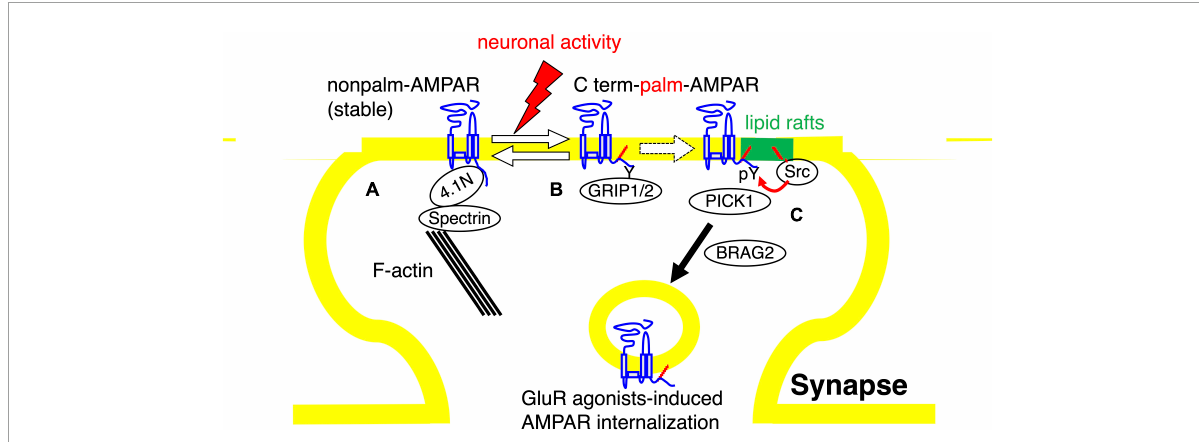
FIGURE3 Model of the role of AMPA receptor palmitoylation in lipid rafts. Diagram of the role of AMPA receptor palmitoylation and tyrosine phosphorylation. (A,B) The balance between palmitoylated and de-palmitoylated forms of the AMPA receptor can be regulated by glutamate receptor agonists treatment, suggesting that synaptic activity can regulate the steady-state level of AMPA receptor palmitoylation. De-palmitoylation of the AMPA receptor on the C-terminal site increases the receptors’ affinity for 4.1N, which stabilizes AMPA receptors at the synaptic surface by the interaction of 4.1N with F-actin and spectrin (A) . In contrast, the palmitoylated forms of surface AMPA receptors are less stably associated with the synaptic membrane and are more susceptible to neuronal activity-induced internalization (B) . (C) The palmitoylated AMPA receptors are assumed to translocate to the synaptic membrane lipid rafts, where the palmitoylated Src family protein tyrosine kinases are concentrated. Phosphorylation of GluA2 at Tyr876 by Src family protein tyrosine kinases induces the exchange of AMPA receptor-binding proteins from GRIP1/2 to PICK1 and the receptor interaction with BRAG2, which drive endocytosis of surface AMPA receptors.